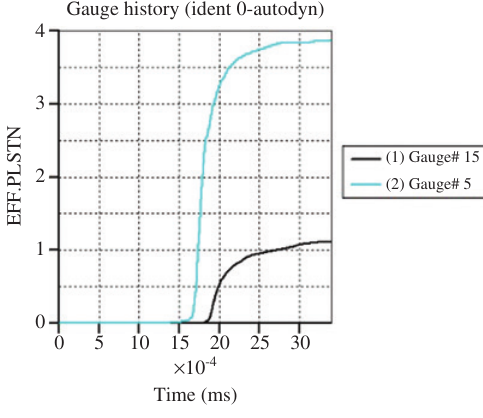
Figure 10: Effective plastic strain profiles of combination in flyer and base plate.